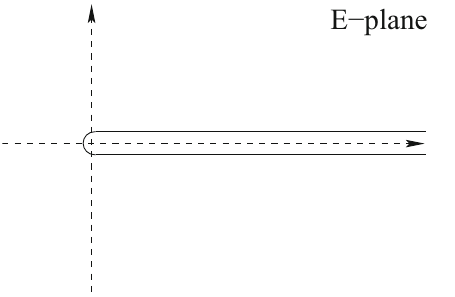
Fig. 3 Integration contour used for the dispersion relation of t ( E ) − 1 giving rise to Eq. (36). The contour is closed by a circle centered at the origin and of infinite